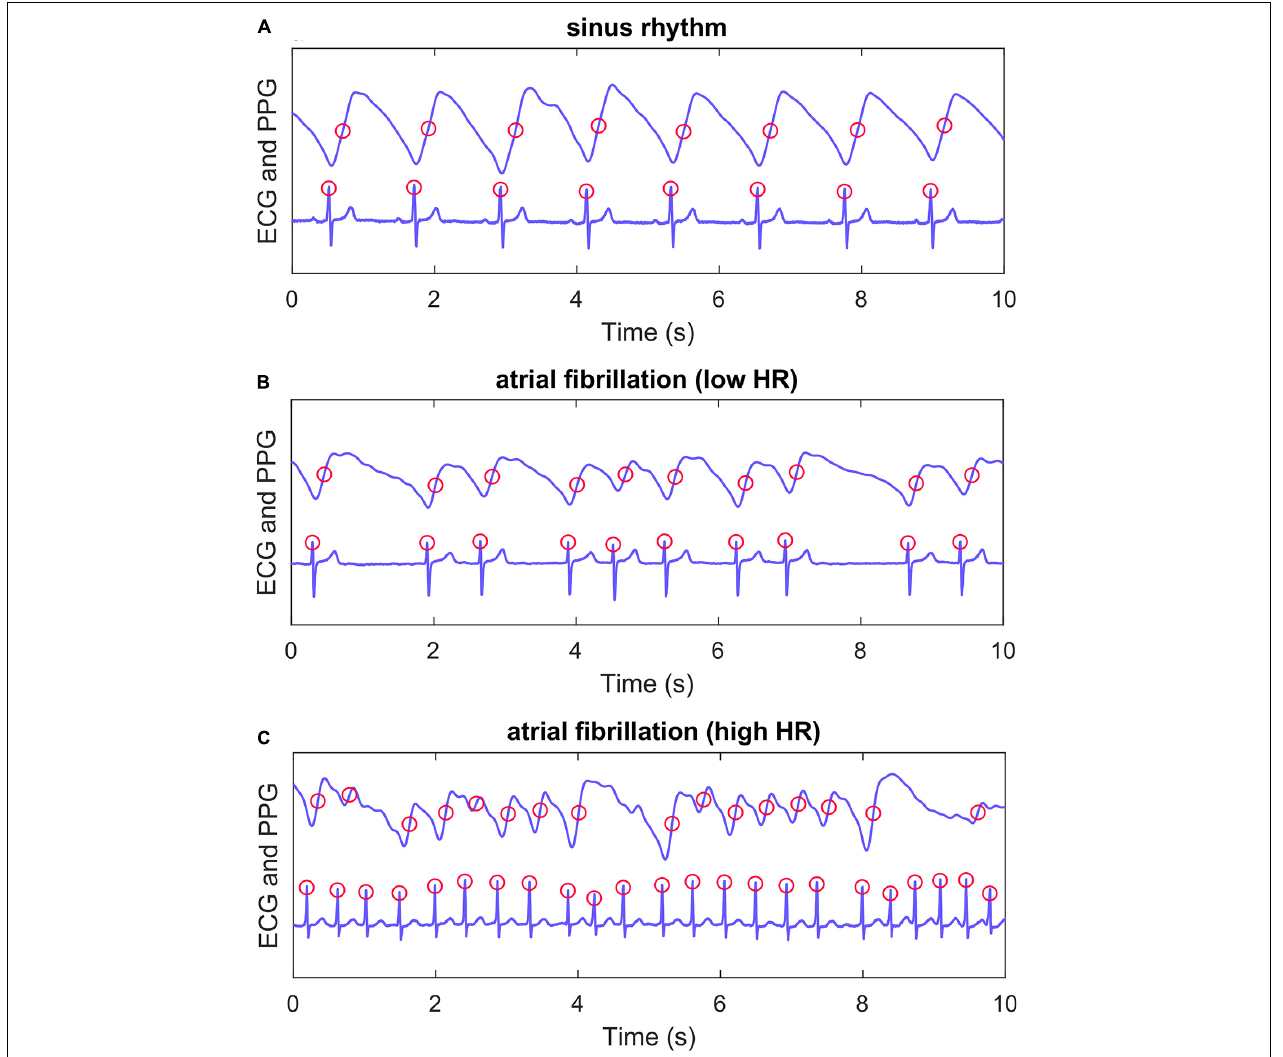
FIGURE 2 | Example recordings. PPG (upper) and ECG (lower) recordings from three patients. Panel (A) shows a patient with sinus rhythm, panel (B) atrial fibrillation with lenient heart rate and panel (C) atrial fibrillation with high heart rate. Algorithm ECG QRS detection points and PPG pulse detection points are marked with red circles. A PIN time series was formed with detected PPG pulses for PIN-based AF detection features. ECG, electrocardiogram; PPG, photoplethysmography; HR, heart